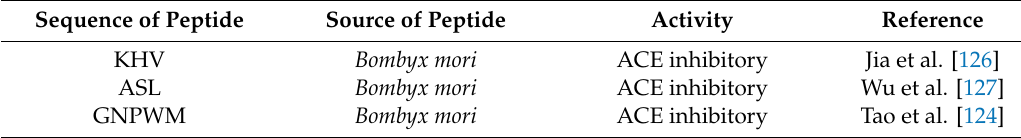
Table 4. Peptide sequence with ACE inhibitor